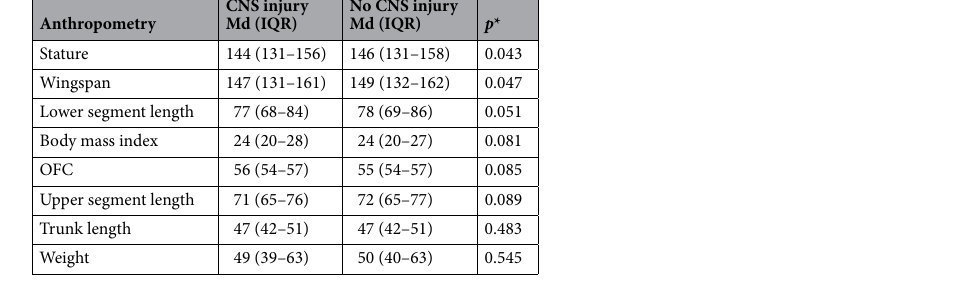
Table 3. Comparison of anthropometric measures between genetic skeletal disorder patients with and without CNS injury. CNS central nervous system, Md median, Q1 first quartile, Q3 third quartile, OFC occipitofrontal circumference. *Mann–Whitney–Wilcoxon